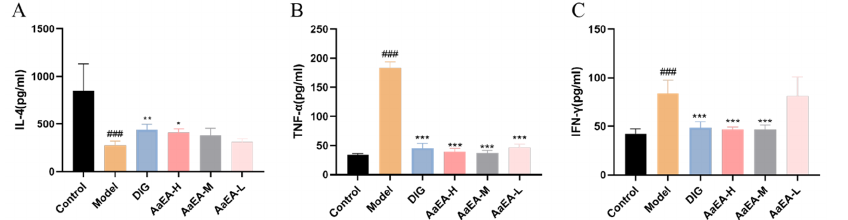
Figure 5. Effects of AaEA on IL-4 ( A ), TNF- α level ( B ), and IFN- γ (C) activities in liver tissues (n = 6). Unless indicated, no significant difference was observed between groups. Compared with the control group, ### p < 0.001. Compared with model group, *** p < 0.001, ** p < 0.01, and * p < 0.05.